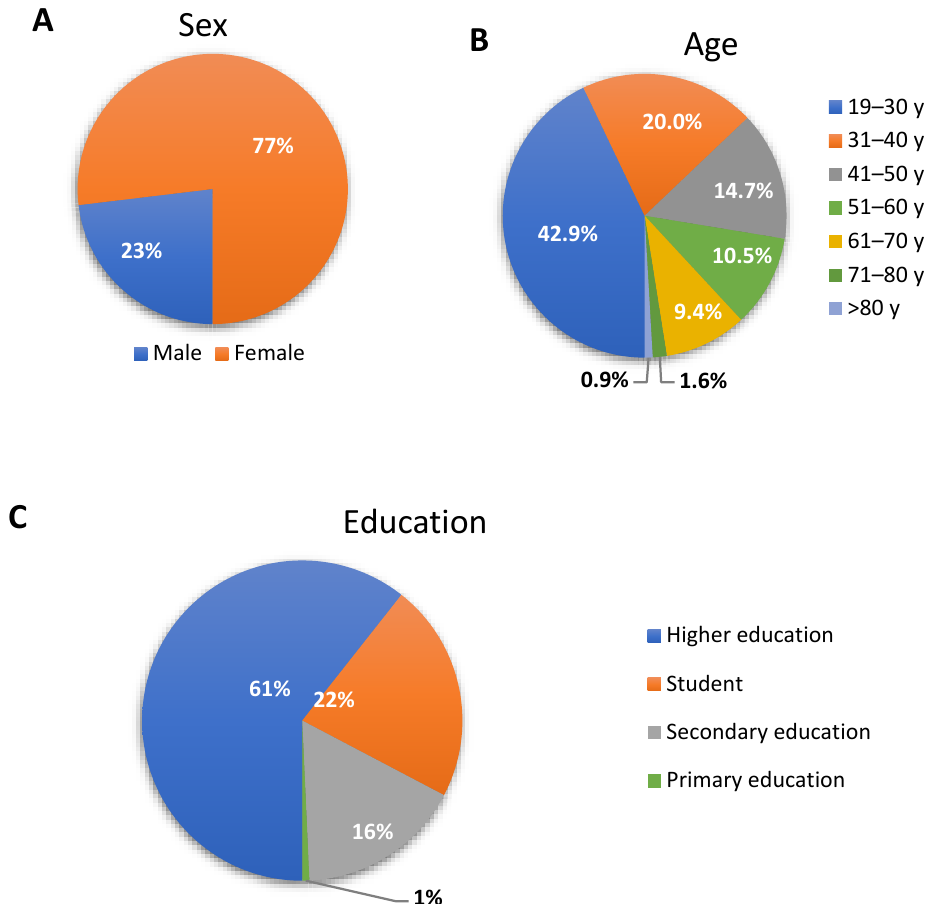
Figure 1. The characteristics of the study group. ( A ) Sex, ( B ) Age (y—years), ( C )